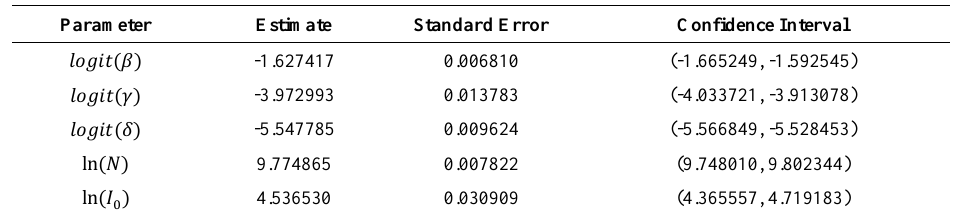
Table A6. Veneto. Estimates, asymptotic standard errors, and 95% profile likelihood mCIs for the parameters of the SIRD model (12).